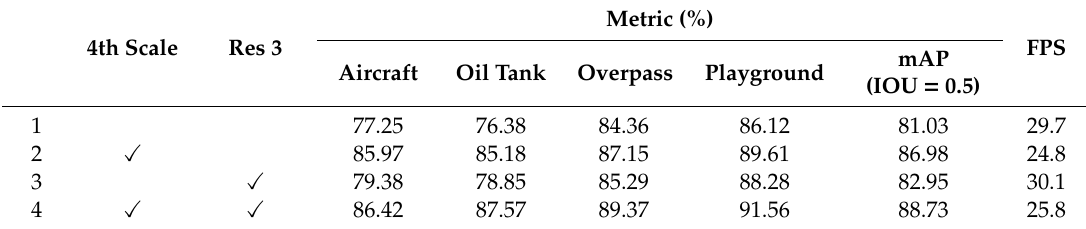
Table 11. Experimental comparisons of each combination in detection